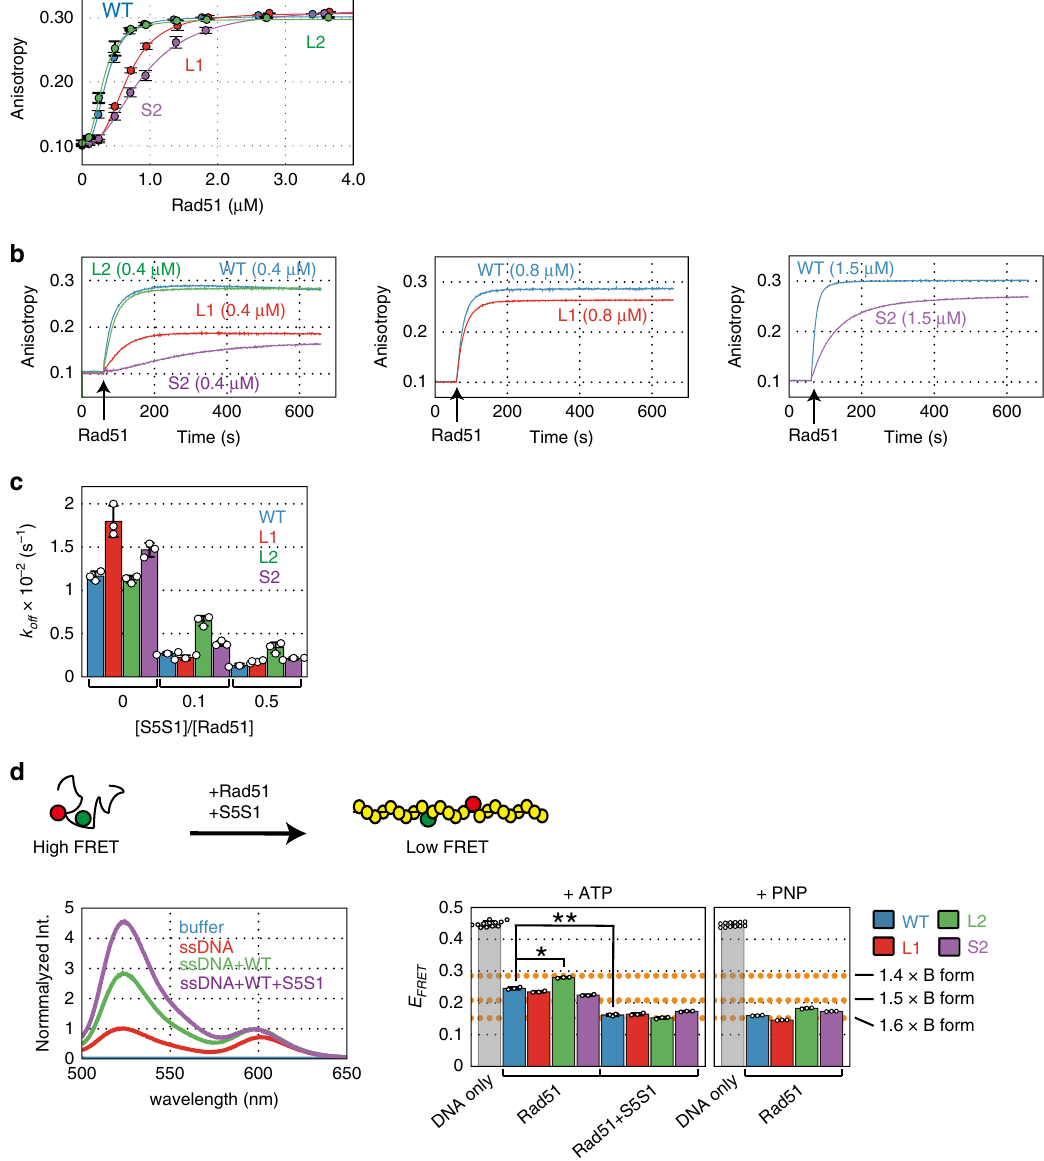
Fig. 5 Formation and elongation of presynaptic fi laments formed by Rad51 DNA binding site mutants. a Formation of presynaptic fi laments by wild-type and mutant Rad51 proteins was observed by measuring fl uorescence anisotropy. Rad51 protein was titrated into the reaction mixture containing ssDNA (3 µ M nucleotide). Wild-type Rad51; blue, Rad51-L1; red, e, Rad51-L2; green, Rad51-S2; purple. b Kinetics of the association between Rad51 and ssDNA. Wild-type or mutant Rad51 protein was injected into a cuvette containing TAMRA-labeled ssDNA 60 s after measurement of fl uorescence anisotropy started, as described in “ Methods ” . (left) Association kinetics of wild-type Rad51 (blue), Rad51-L1 (red), Rad51-L2 (green), and Rad51-S2 (purple) (0.4 µ M each) on TAMRA-labeled ssDNA (1.2 µ M). (center) Association kinetics of wild-type Rad51 and Rad51-L1 (0.8 µ M each) on TAMRA-labeled ssDNA (2.4 µ M). (right) Association kinetics of wild-type Rad51 and Rad51-S2 (1.5 µ M) on TAMRA-labeled ssDNA (4.5 µ M). c Dissociation rate constants of the DNA binding mutants from ssDNA, calculated from the dissociation assays in Supplementary Fig. 4. d Elongation of the presynaptic fi lament. (upper) Schematic diagram depicting observation of the elongation of the presynaptic fi lament using FRET. Yellow balls represent Rad51 monomers. Green and red balls represent fl uorescein and rhodamine, respectively. (lower left) Emission spectra of fl uorescein and rhodamine, which are separated by 11 nucleotides, collected by excitation at 493 nm. Wild-type Rad51 (3 µ M) and Swi5-Sfr1 (0.3 µ M) were mixed with double-labeled ssDNA (3 µ M, nucleotide) in the presence of ATP. (lower right) FRET ef fi ciency ( E FRET ) in the presence of ATP or AMP-PNP was calculated from the emission spectra shown here and in Supplementary Fig. 5. Orange dot-lines show the distances between two fl uorophores compared with B-form DNA. * p = 1.53 × 10 − 4 and ** p = 8.64 × 10 − 6 , by two-tailed Student ′ s t test. Data ( a , c , d ) are expressed as the mean ± s.d. ( n = 3 independent experiments, except n = 12 for DNA only in d ). Source data are provided as a Source data fi